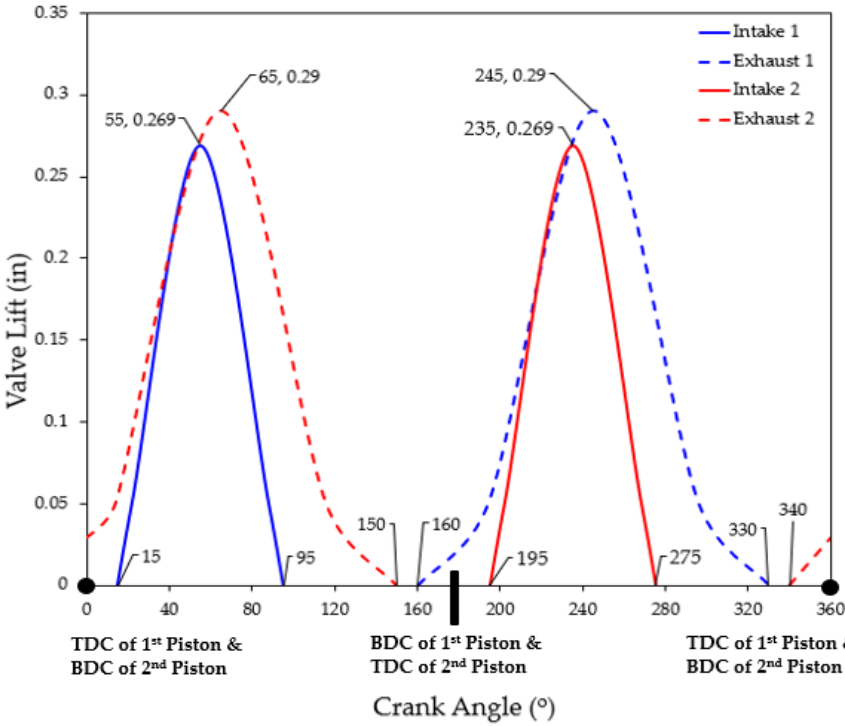
Figure 9. Valve timing and lift profiles for a full crank rotation—360°.